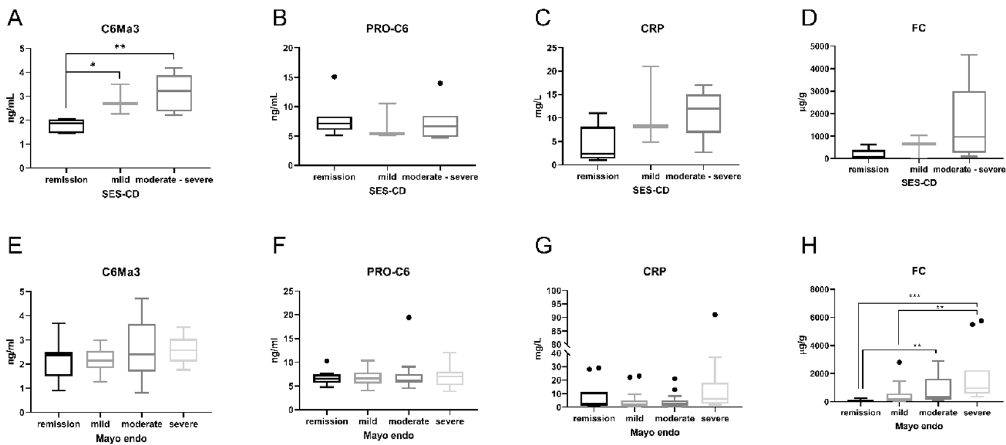
Figure 2. Levels of the biomarkers C6Ma3 ( A , E ), PRO-C6 ( B , F ), CRP ( C , G ), and FC ( D , H ) in CD and UC patients grouped by the endoscopic scoring indexes SES-CD and Mayo endo. Ordinary one-way ANOVA with Tukey’s multiple comparisons tests and Kruskal–Wallis with Dunn’s test for multiple comparison were used to test for difference in biomarker levels between groups. *p < 0.05, **p < 0.01, ***p <